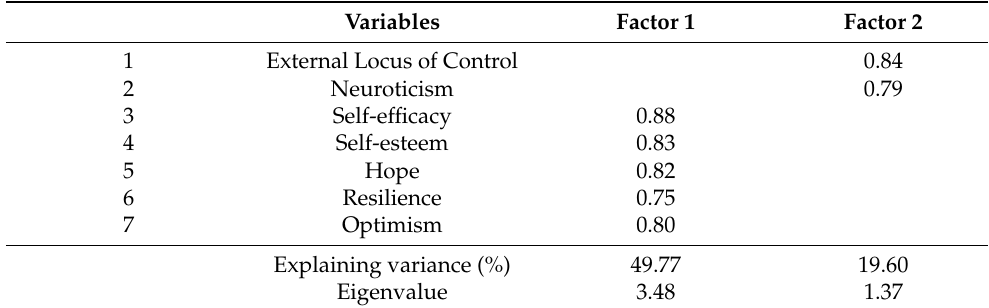
Table 2. Exploratory Factor Analysis of the Core Self-Evaluations and Psychological Capital Scales.